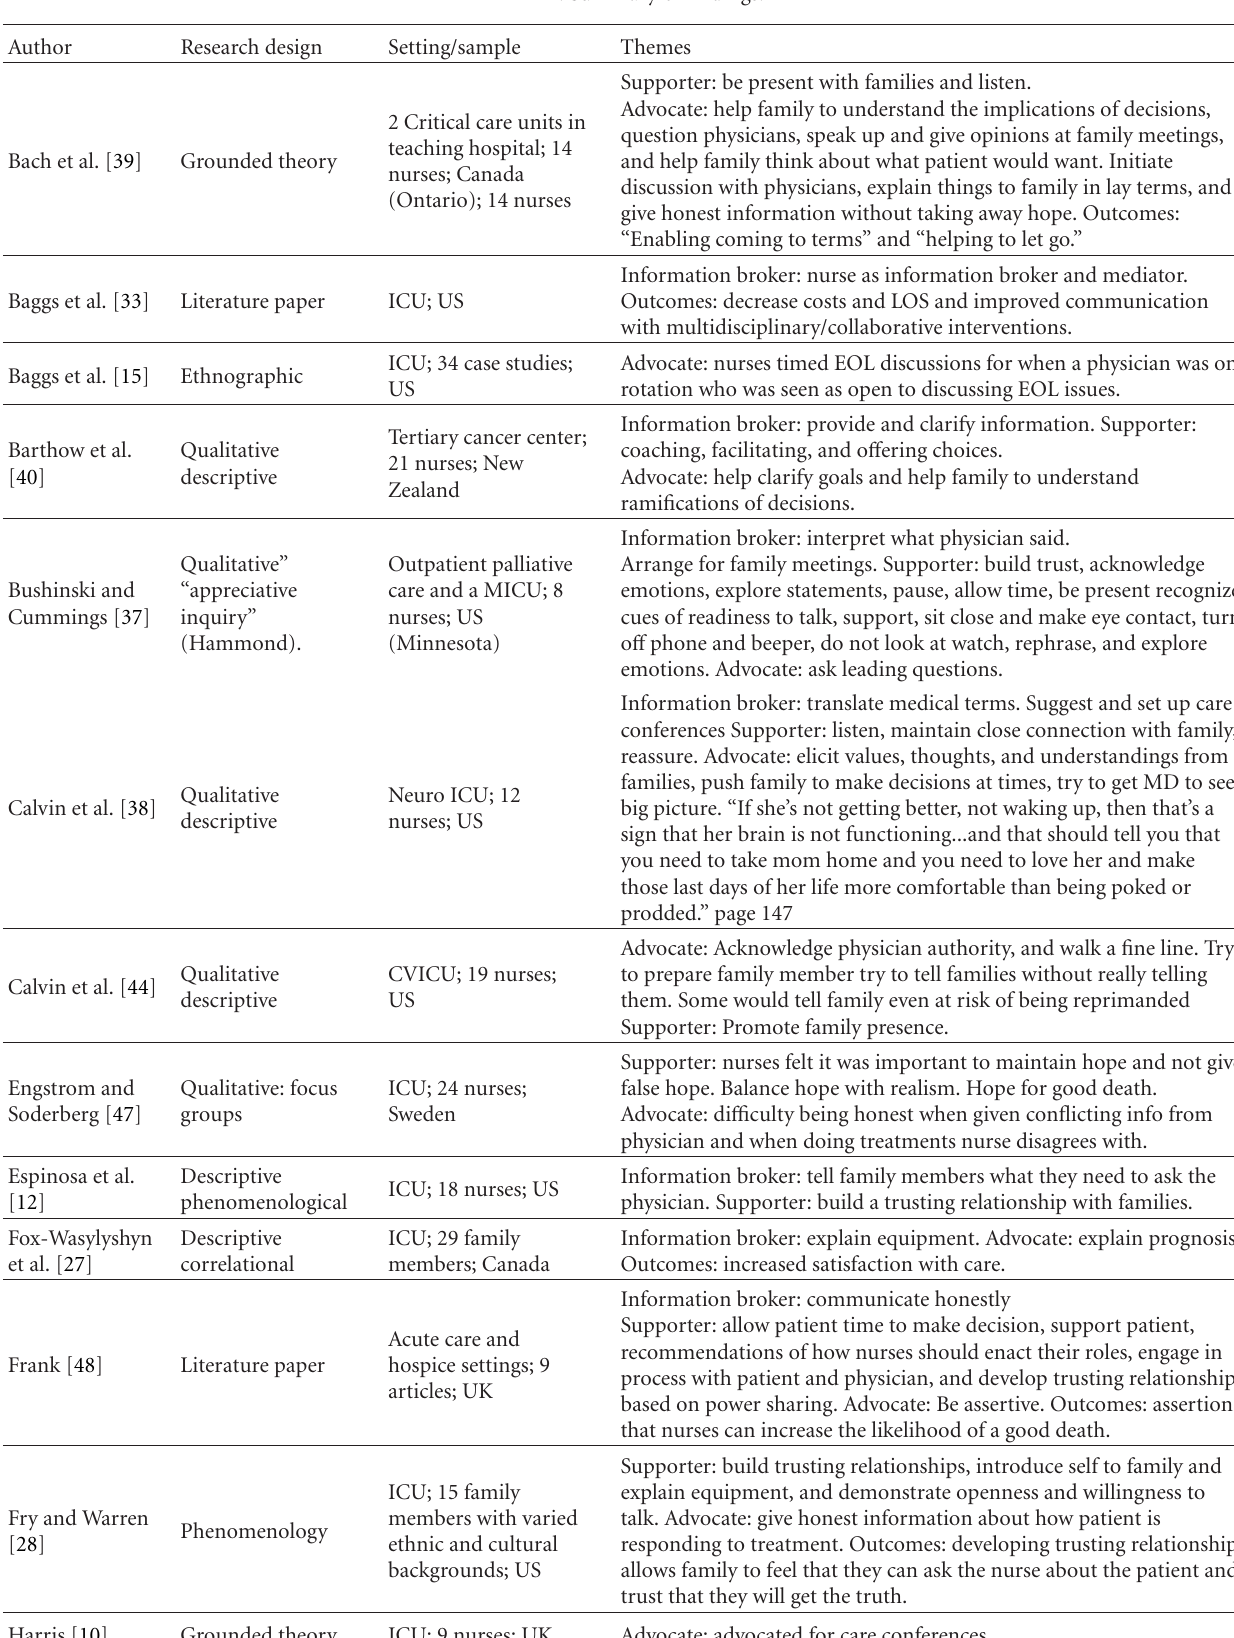
Table 1: Summary of